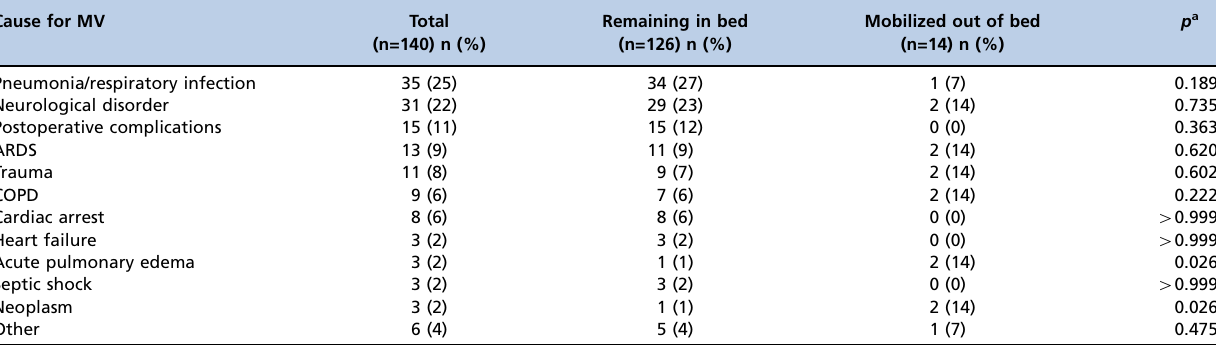
Table 4 - Main cause of MV.